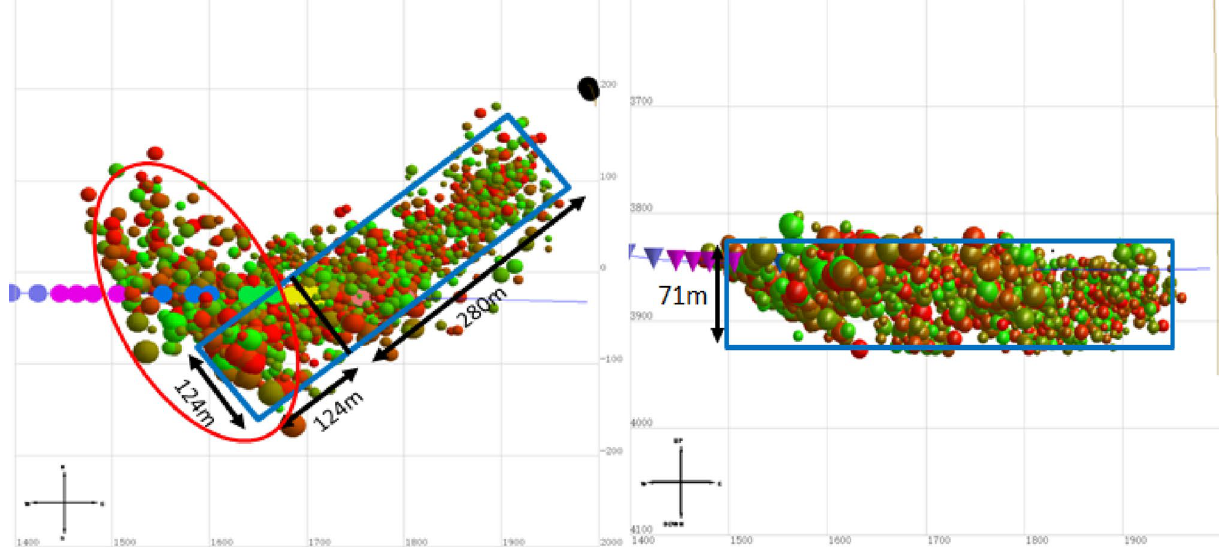
Fig. 15 Top view (left) and side view (right) of